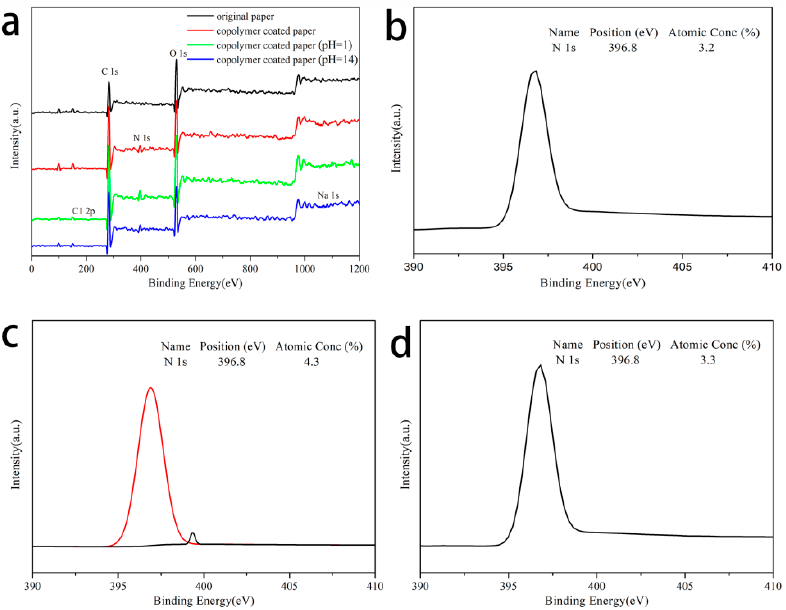
Figure 9. ( a ) XPS spectra. N 1s core level of ( b ) copolymer coated paper, ( c ) modified paper treated with acid, and ( d ) modified paper treated with an alkali, respectively.